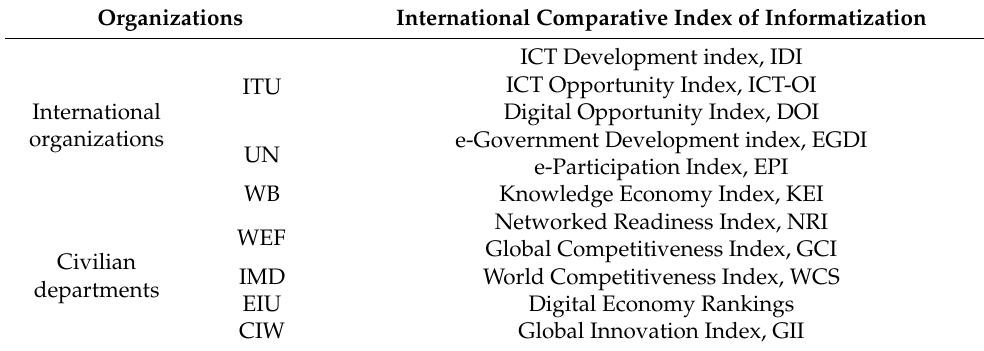
Table 1. International comparative index of major